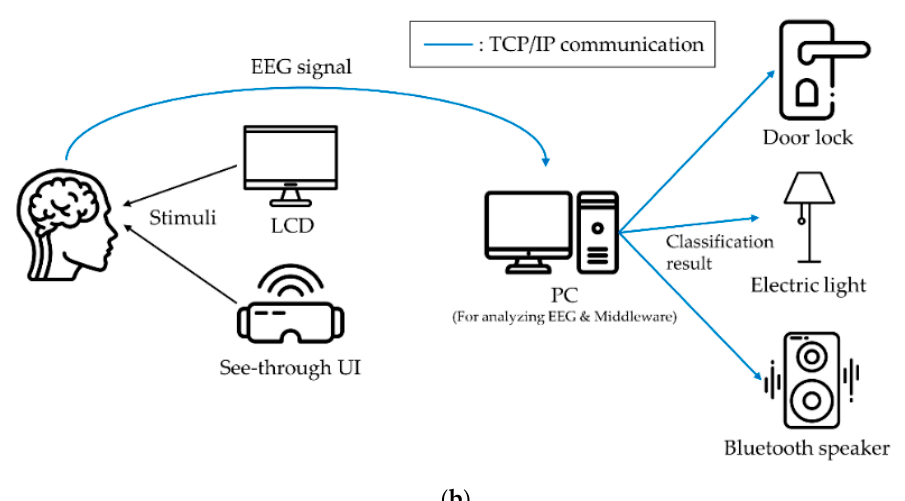
Figure 1. ( a ) The experimental design to build brain–computer interfaces (BCIs) for controlling three different home appliances: door lock, electric light, and Bluetooth speaker. Participants performed 50 training blocks followed by 30 test blocks. User interfaces provided to participants for controlling each home appliance are shown. ( b ) An overall diagram of the communication network between electroencephalography (EEG)-based BCIs and home appliances through TCP/IP communication.